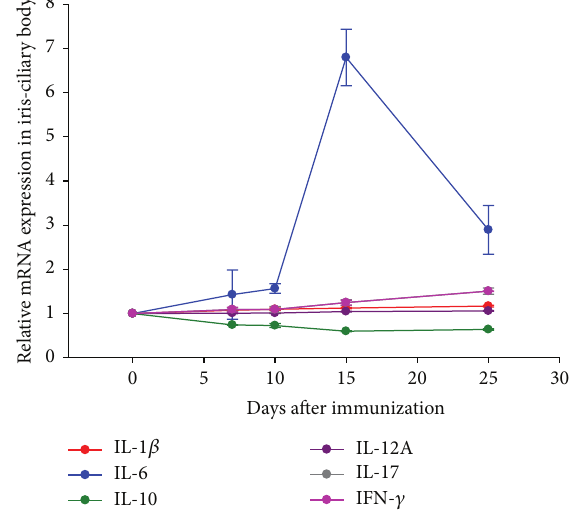
Figure 5: Summary of relative expression levels of mRNA of the target cytokines in iris/ciliary bodies. Because of the space limit, IL- 17 and IL-12A coincide in the